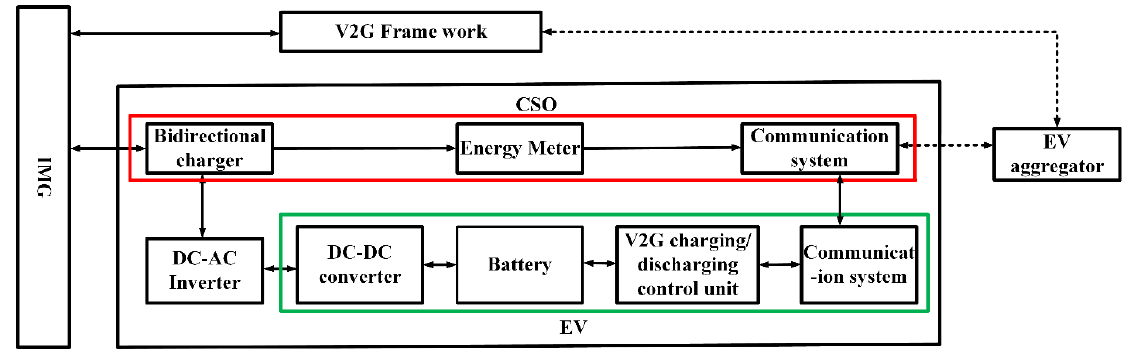
Figure 3. Illustrative representation of the charging station operator (CSO).